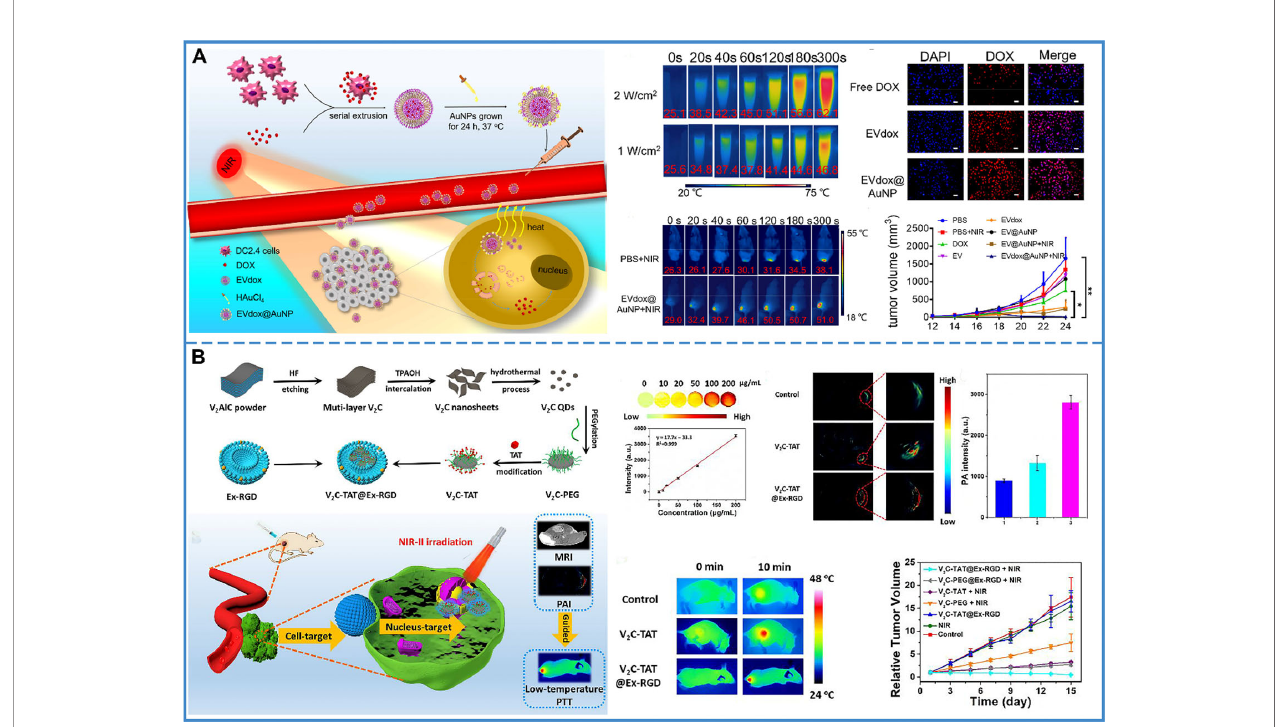
FIGURE 7 | Photothermal therapy. (A) The prepared EVdox@AuNP (EVs encapsulating DOX were fi rst obtained (EVdox), and self-growth of gold nanoparticles around EVdox) plays a synergistic role of photothermal and chemotherapy for tumor treatment. In this system, AuNPs have a good thermal effect and exosomes can assist DOX aggregation within tumor cells, thus inducing effective tumor elimination. Reproduced with permission from ref (177). Copyright 2019 Elsevier. (B) V2C- TAT@Ex-RGD (The small fl uorescent V2C QDs were modi fi ed with TAT peptides and packaged into Ex with RGD modi fi cation) targeted the cancer cell membrane & nucleus organelle for low-temperature imaging-guided PTT in NIR-II. The PA intensity at the tumor site was 2.11-fold higher in V2C-TAT@Ex-RGD-treated mice than in V2C-PEG-TAT-treated mice. It was shown that the ef fi cient tumor accumulation of V2C-TAT@Ex-RGD was due to the Ex-RGD coating. After 10 min of 1064 nm laser irradiation at a power density of 0.96 W/cm 2 , the tumor site warming was higher in the V2C-TAT@Ex-RGD-treated mice compared with the control group and the V2C-TAT-treated mice. And, the V2C-TAT@Ex-RGD +1064 nm laser irradiation group could effectively inhibit tumor growth without recurrence. Reproduced with permission from ref (178). Copyright 2019 American Chemical